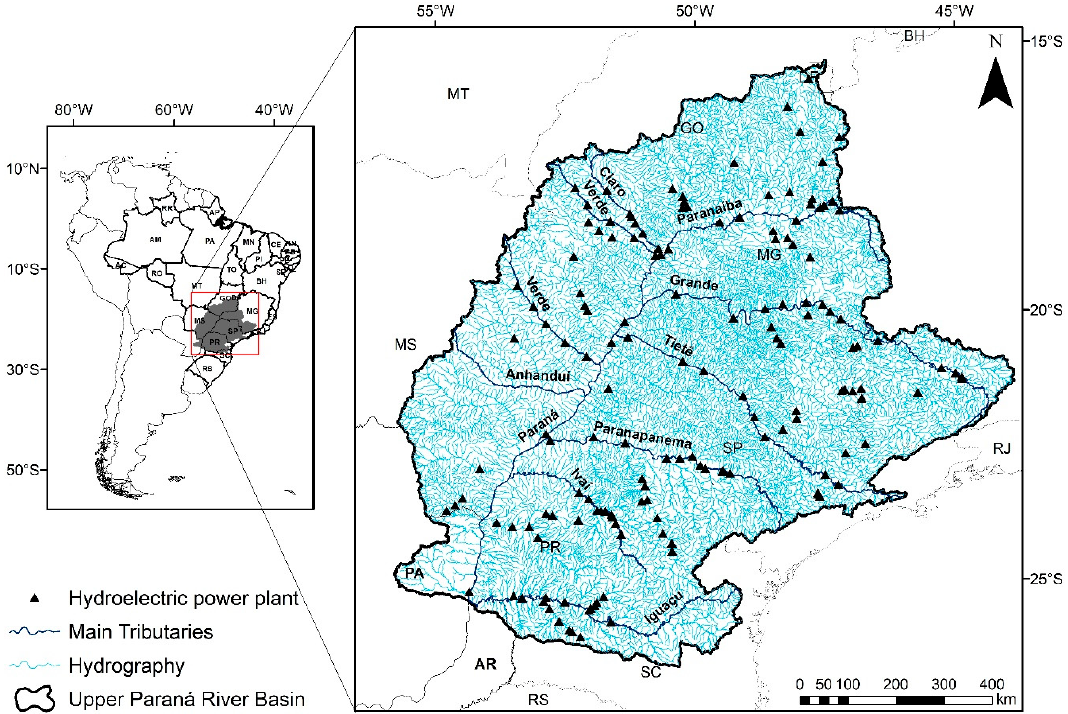
Figure 1. Geographic location of the study area. Blue lines show the hydrography and main tributaries, and black triangles show the hydroelectric power plants (installed or planned) over the Upper Paraná River Basin (UPRB).